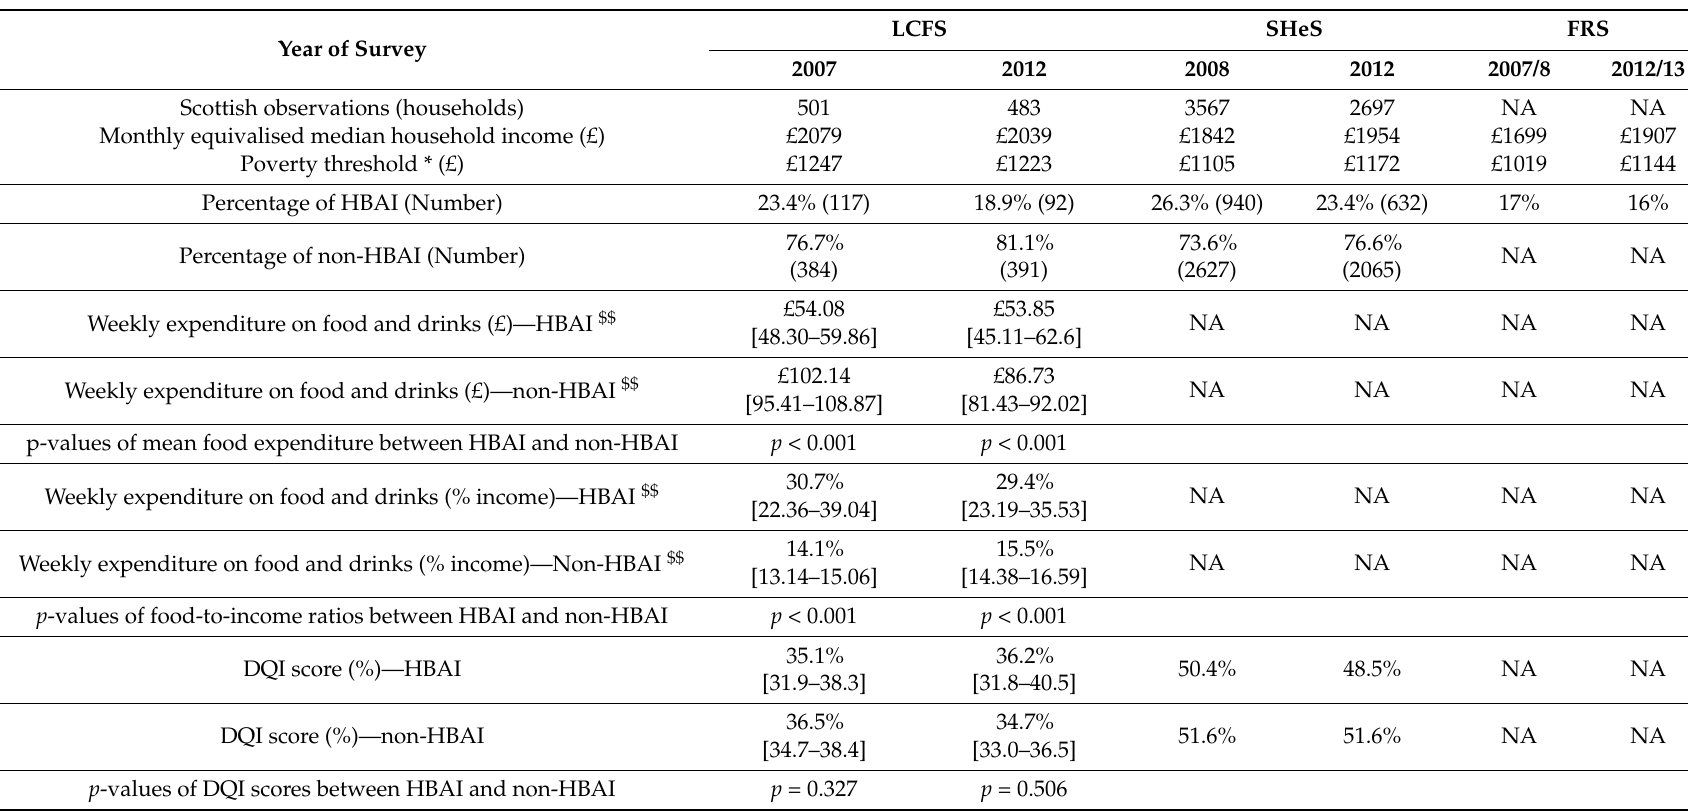
Table 1. Prevalence of households below 60% median income in Living Costs and Food Survey (LCFS), Scottish Health Survey (SHeS) and the Family Resources Survey (FRS), along with mean weekly expenditure and measures of diet